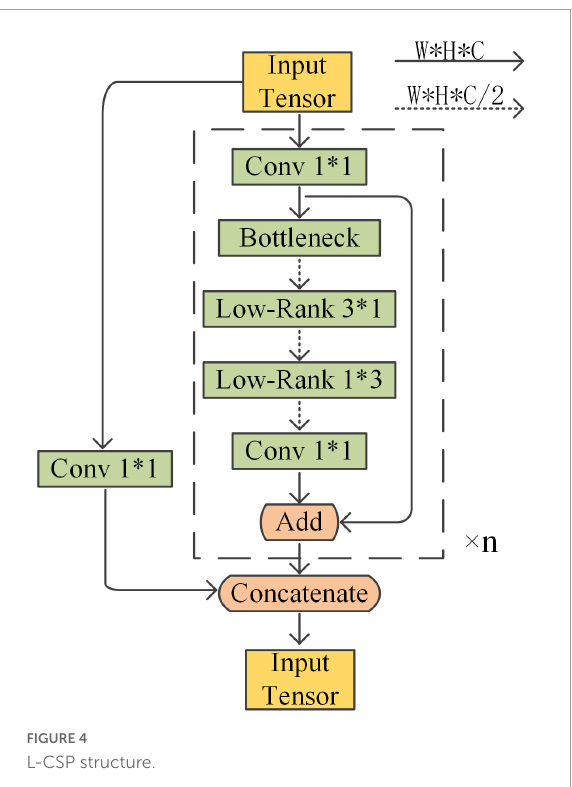
FIGURE4 L-CSP structure.